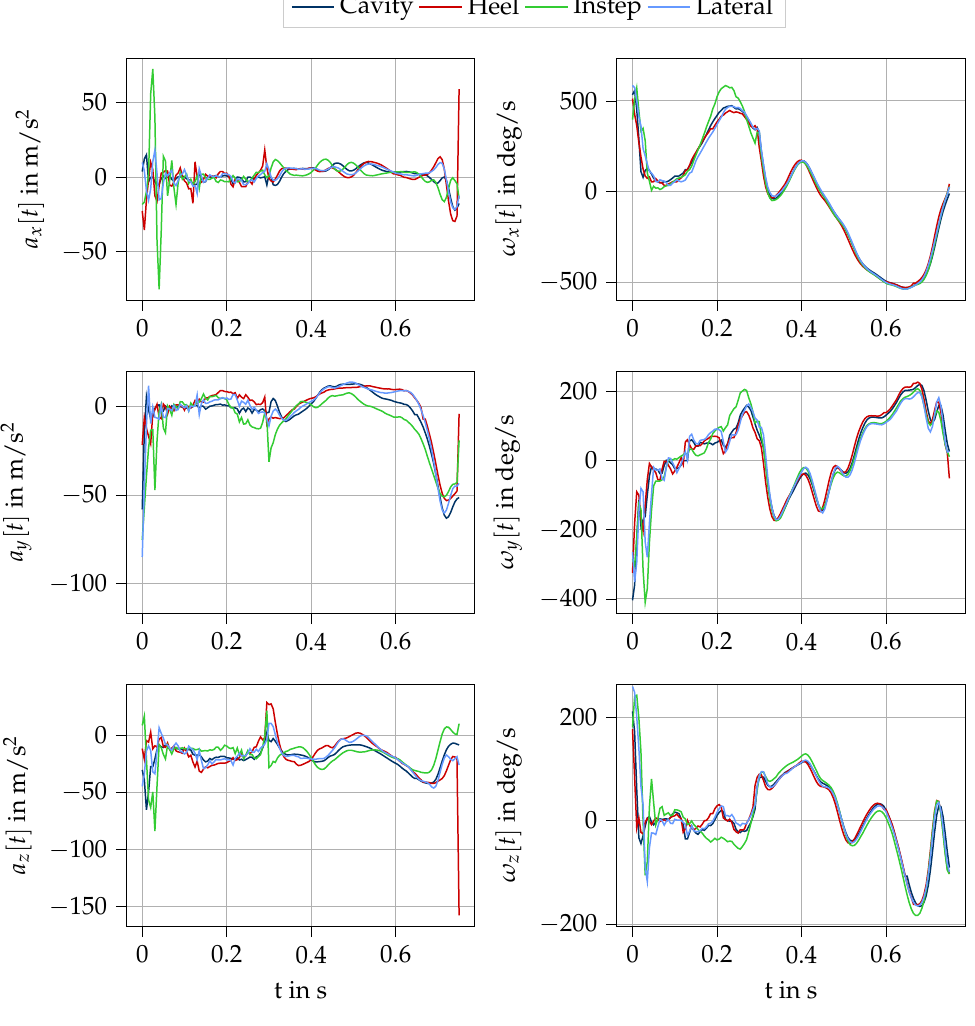
Figure 5. Exemplary IMU data of one stride segmented from IC to IC for the four different sensor